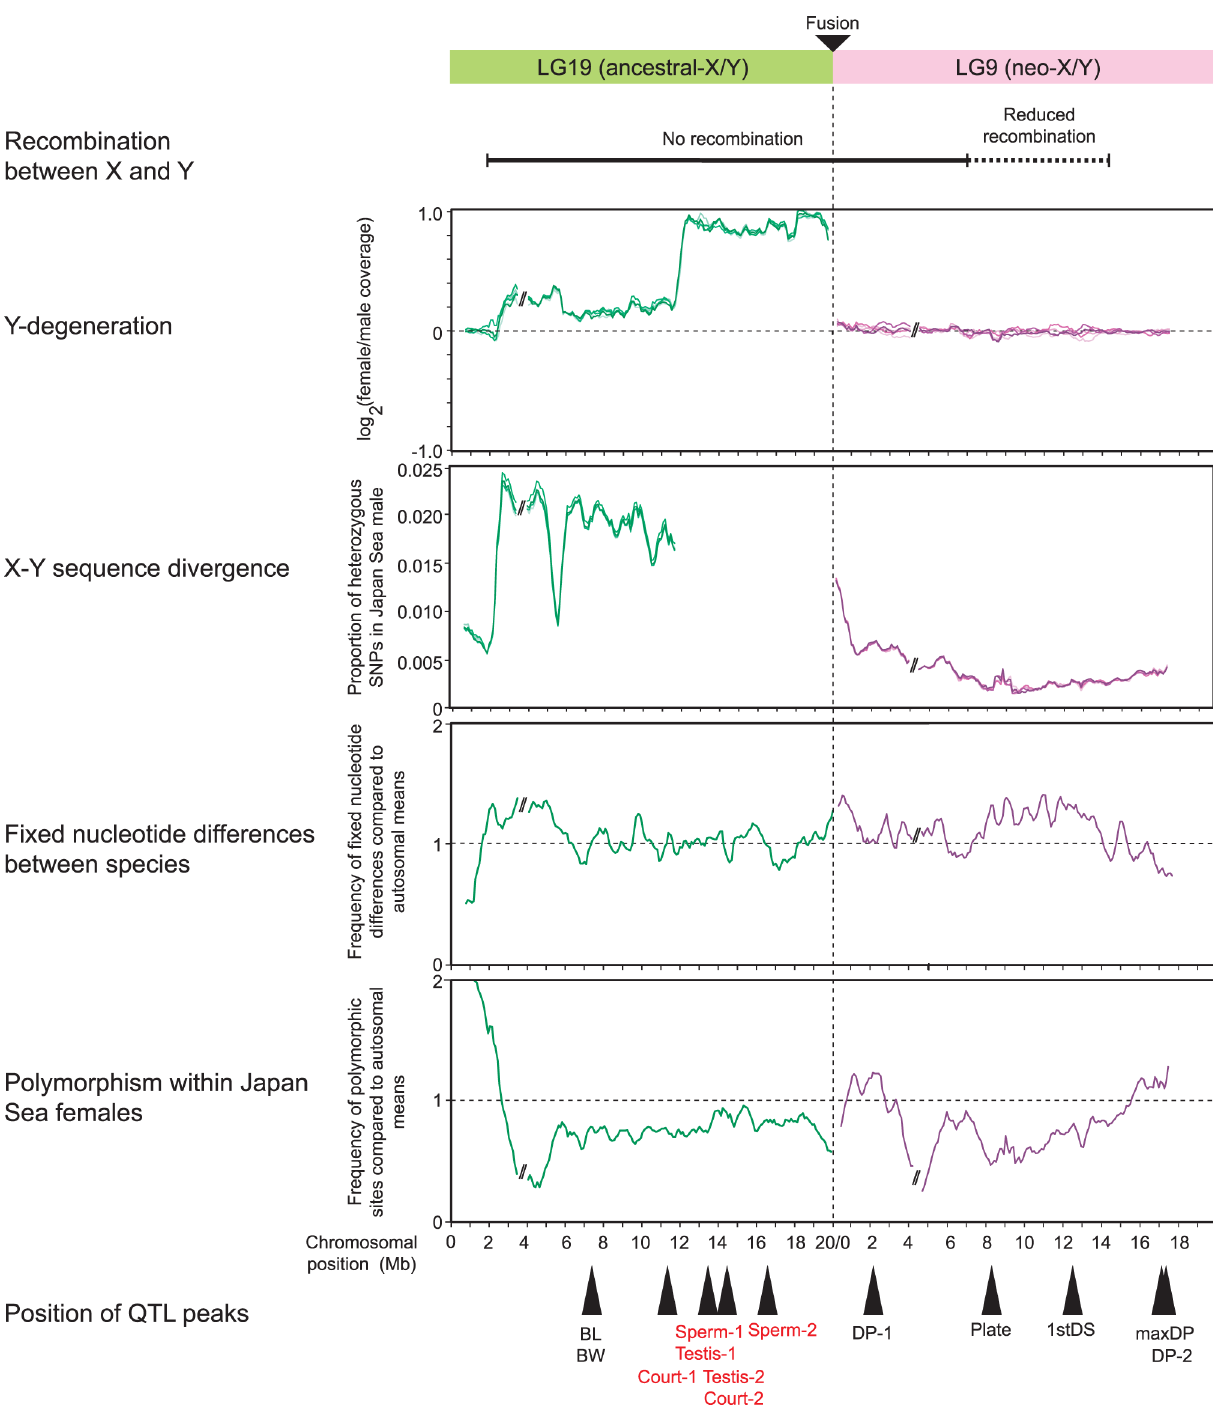
Figure 7. Summary of results of genomic analysis and QTL mapping for LG9 and LG19. Recombination rate data are based on previous reports [18,50,51]. Only QTL for traits that differ between the species and/or contribute to reproductive isolation are shown here, so the QTL controlling ectocoracoid bone length and pelvic spine length on LG19 are not shown, because these two traits did not differ between species (Table S3). QTL for hybrid incompatibility are shown in red. Testis-1 and Testis-2, testis size; Court-1 and Court-2: courtship dysfunction; Sperm-1 and Sperm- 2, sperm number; BL, body length; BW, body weight; DP-1 and DP-2, mean dorsal pricking intensity; Plate, caudal plate height; 1stDS, first dorsal spine length; maxDP, maximum dorsal pricking intensity. between markers located at the fusion end (0 Mb) and 7 Mb with least in the 14.4 Mb of LG9 proximal to the fusion [18]. These recombination rate gradually decreasing from there to the distal plots indicate that QTL important for phenotypic divergence are end [51], and reduction of recombination rate was observed at distributed across LG9 (Figure 7). One QTL peak (dorsal